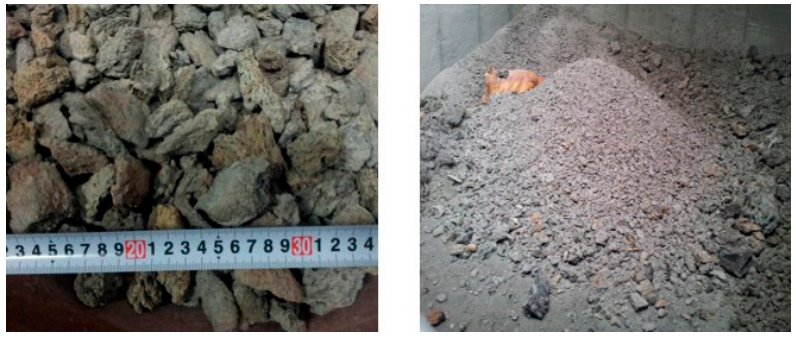
Figure 2. Shape of dBA [7].